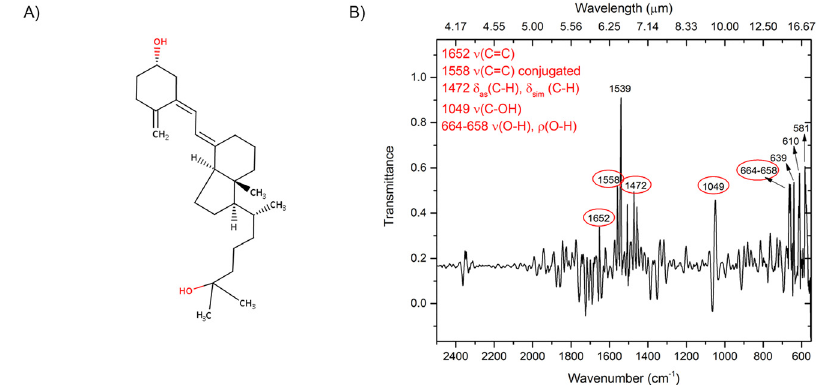
Figure 4: (A) Skeletal formula of 25(OH)D3 monohydrate; (B) Attenuated Total Reflectance-FTIR characterization spectrum of 25(OH)D3 monohydrate: the targeted wavenumbers of interest in our SEIRA ex- periments are marked with red